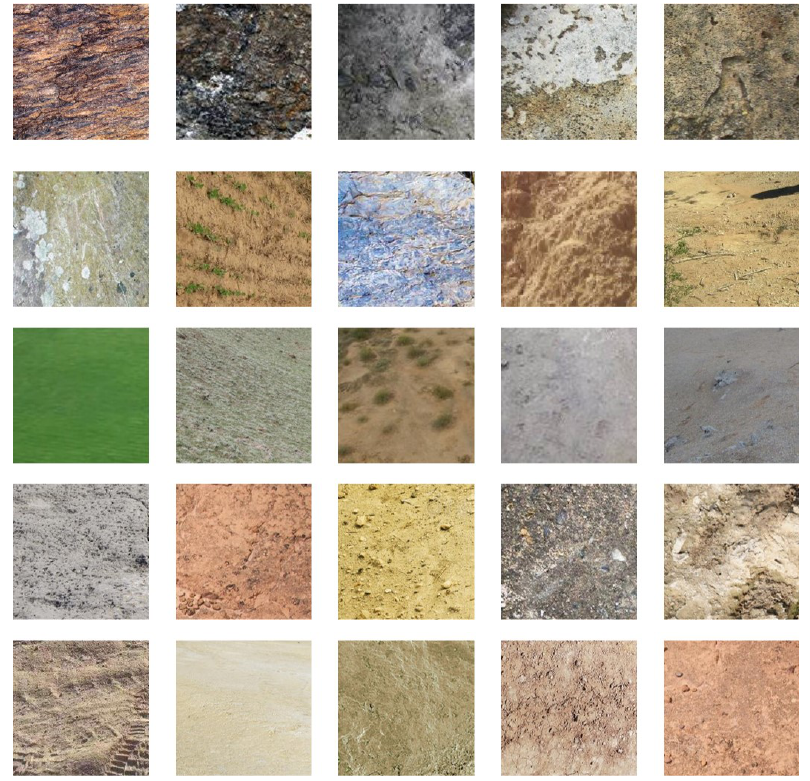
Figure 9. The dataset of surface cracks of soil and rock masses that does not contain the images of the